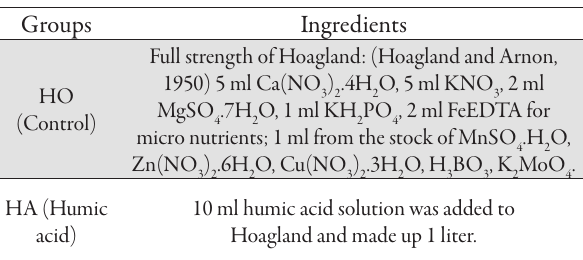
Tab. 2. Experimental groups and